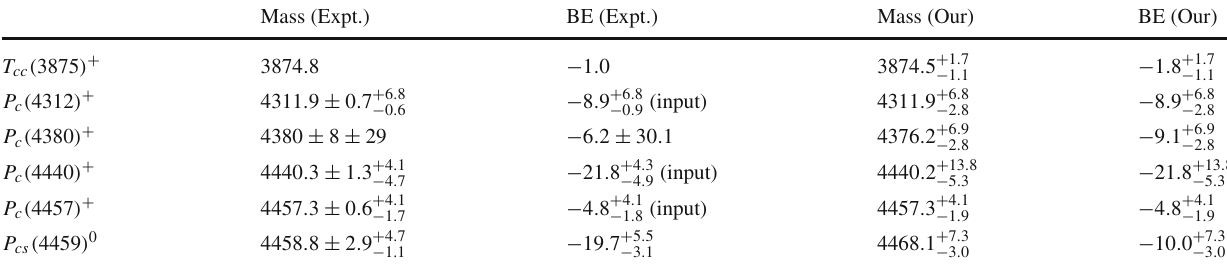
Table 3 The experimental data [14,18,36–38] and our results of the masses and binding energies (BE) for the T + cc , P c ( 4312 ) , P c ( 4380 ) , P c ( 4440 ) , P c ( 4457 ) , and P cs ( 4459 ) . The tiny experimental error for the T cc ( 3875 ) [37,38] is not presented. We use the values (cid:2) = 0 . 33